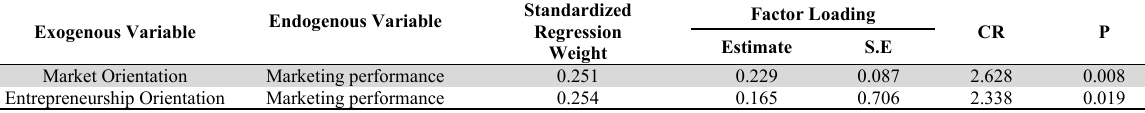
SEM Fourth Hypothesis Test Results. Marketing innovation and guidance on marketing